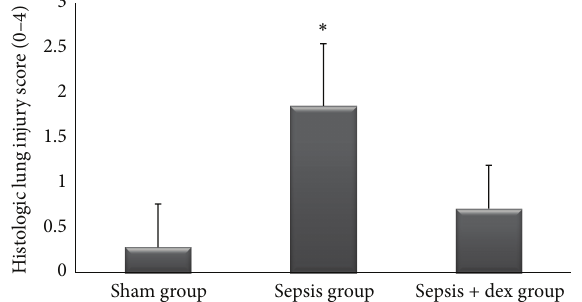
sepsis group compared to sham and sepsis + dex groups (Figure